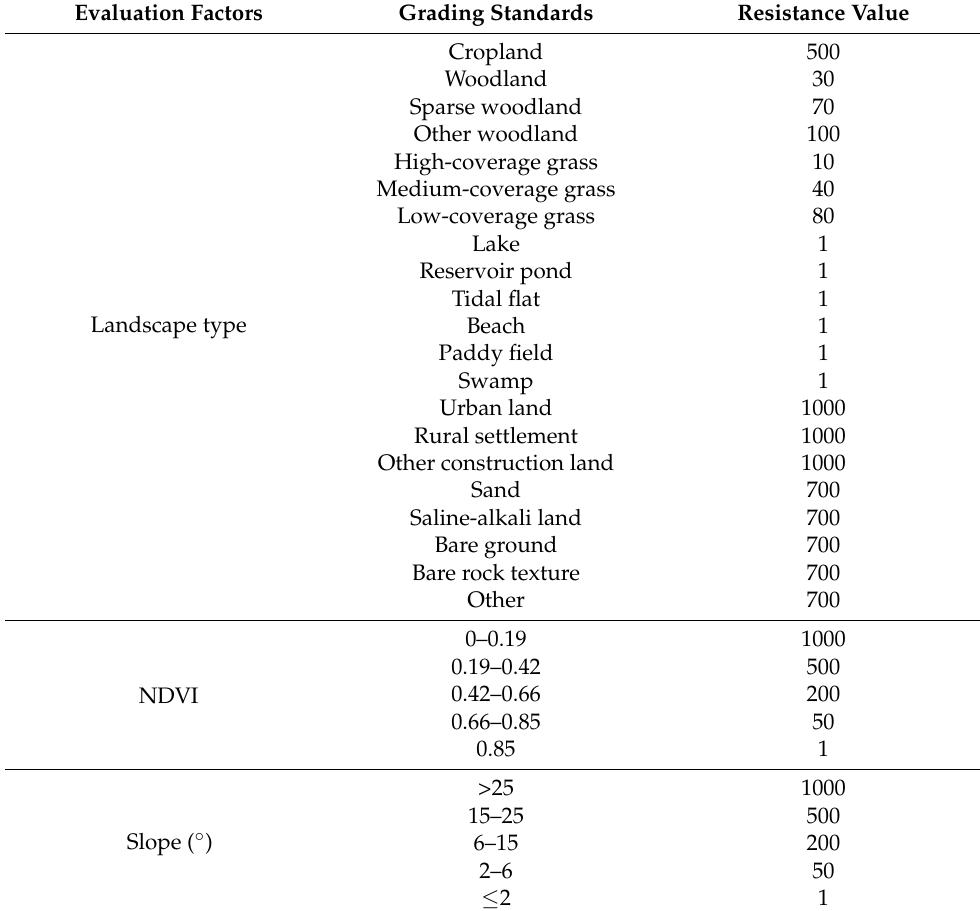
Table 2. Ecological resistance factor evaluation